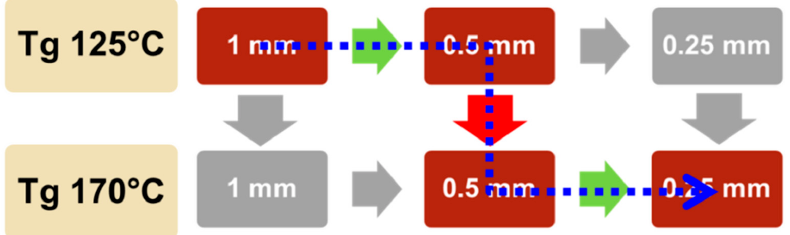
Figure 14. Original test plan superimposed by the actual path followed (blue dotted line).